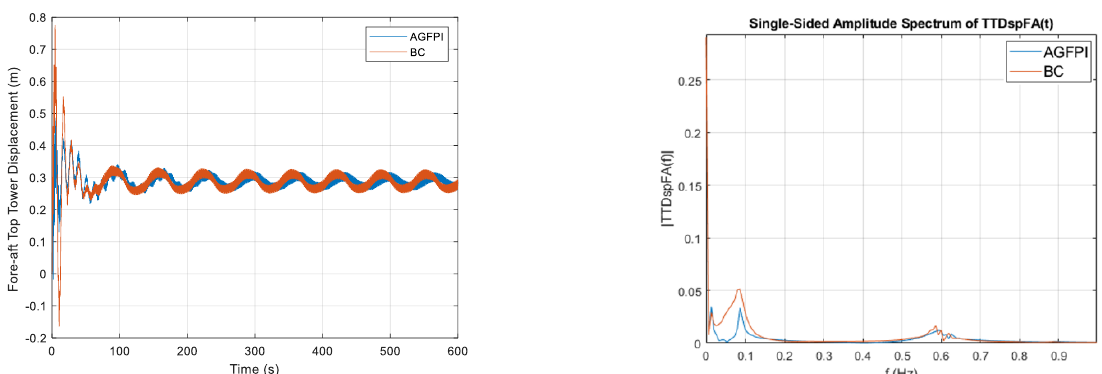
Figure 8. Tower top displacement in the fore – aft direction without waves ( left ) and its single side amplitude spectrum ( right ).